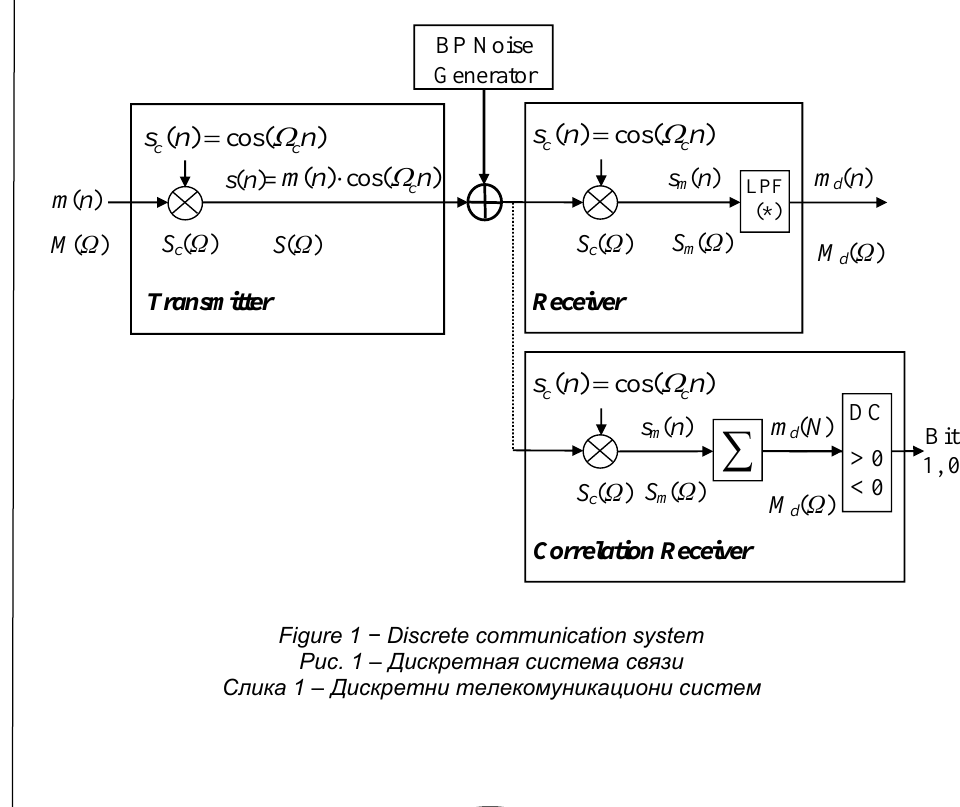
Figure 1 − Discrete communication